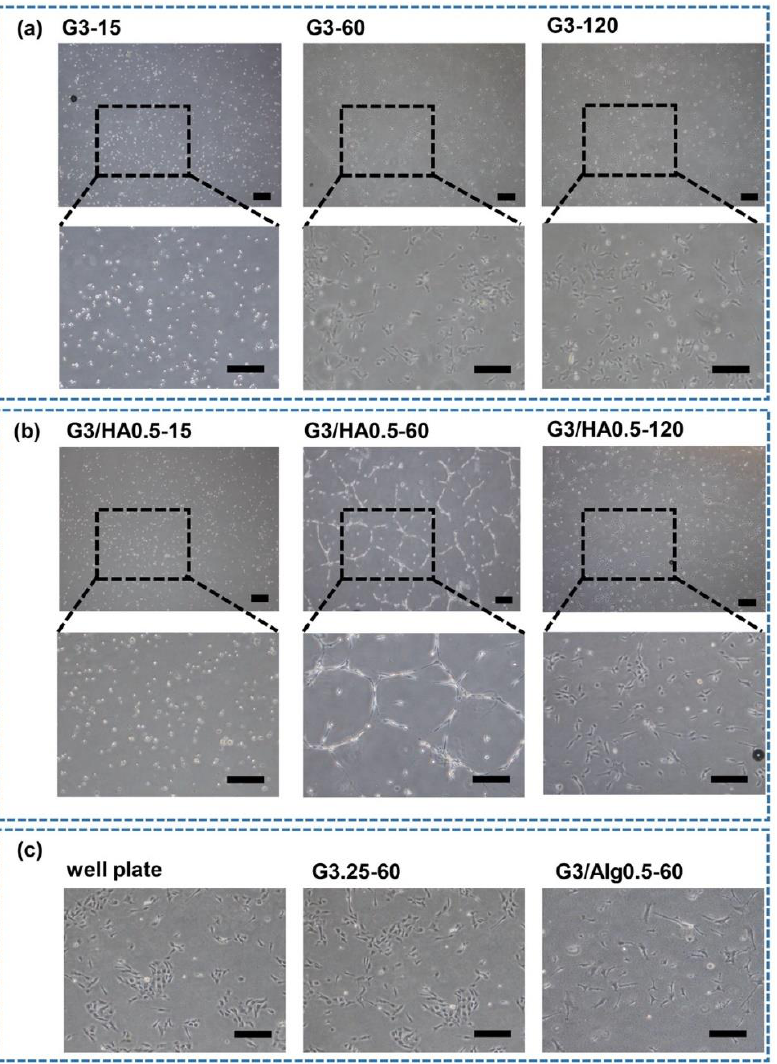
Figure 7. The effect of hydrogel composition and air containing H 2 O 2 exposure time on HUVECs capillary-like network formation. HUVECs were seeded at 4.0 × 10 4 cells/cm 2 on ( a ) G3-15, G3-60, G3-120, ( b ) G3/HA0.5-15, G3/HA0.5-60, G3/HA0.5-120, and ( c ) G3.25-60, G3/Alg0.5-60, and culture well plate (controls). Scale bar: 100 μm.